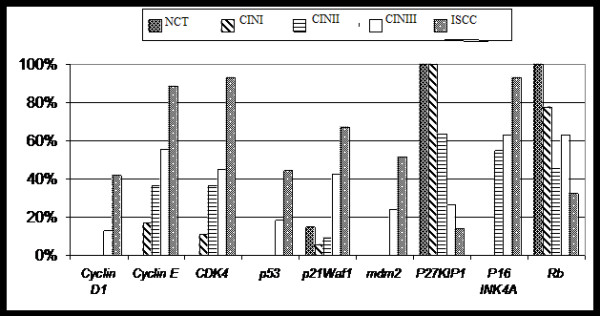
The percentage of protein expression of different studied markers in the studied groups.